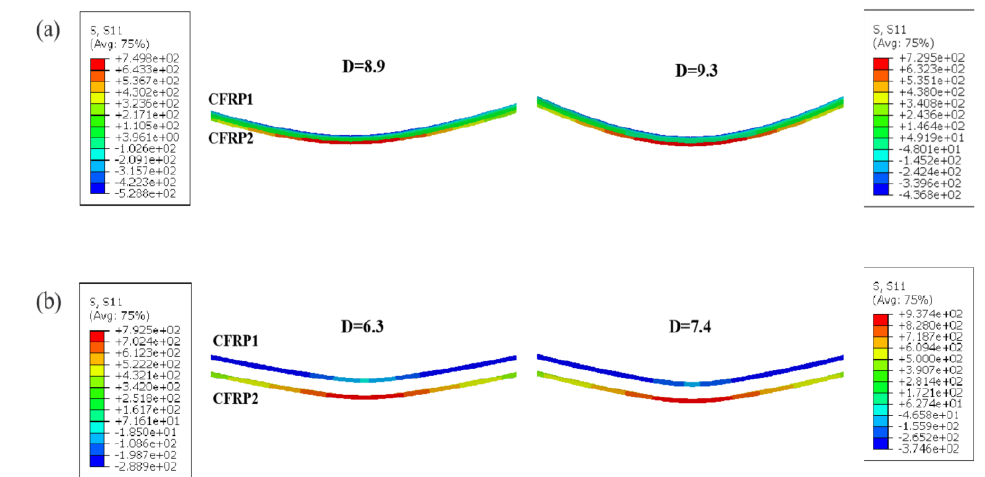
Figure 7. Longitudinal stress contours of 2/1 FMLs and 2/1 FMLs patch after failure ( a ) 2/1 FMLs, ( b ) 3/2 FMLs patch. (On the left is the Linde criterion and on the right is the Hashin